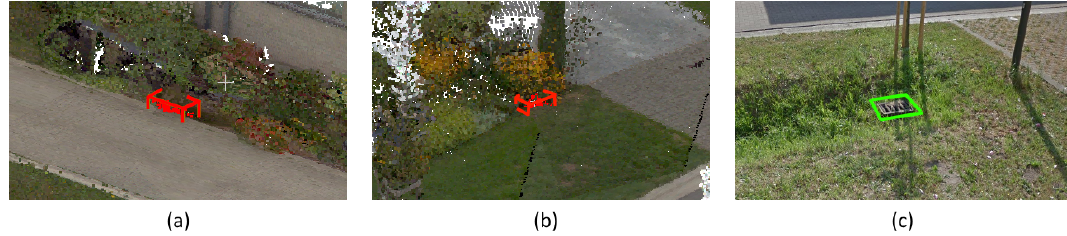
Figure 8. Examples of the false positive detection results. (a) and (b) show false positive detection clusters in red due to low vegetation which was incorrectly segmented as hardscape and complied with the defined requirements. (c) shows a ”false positive” detection in green which was missed during the labelling of the ground truth data.